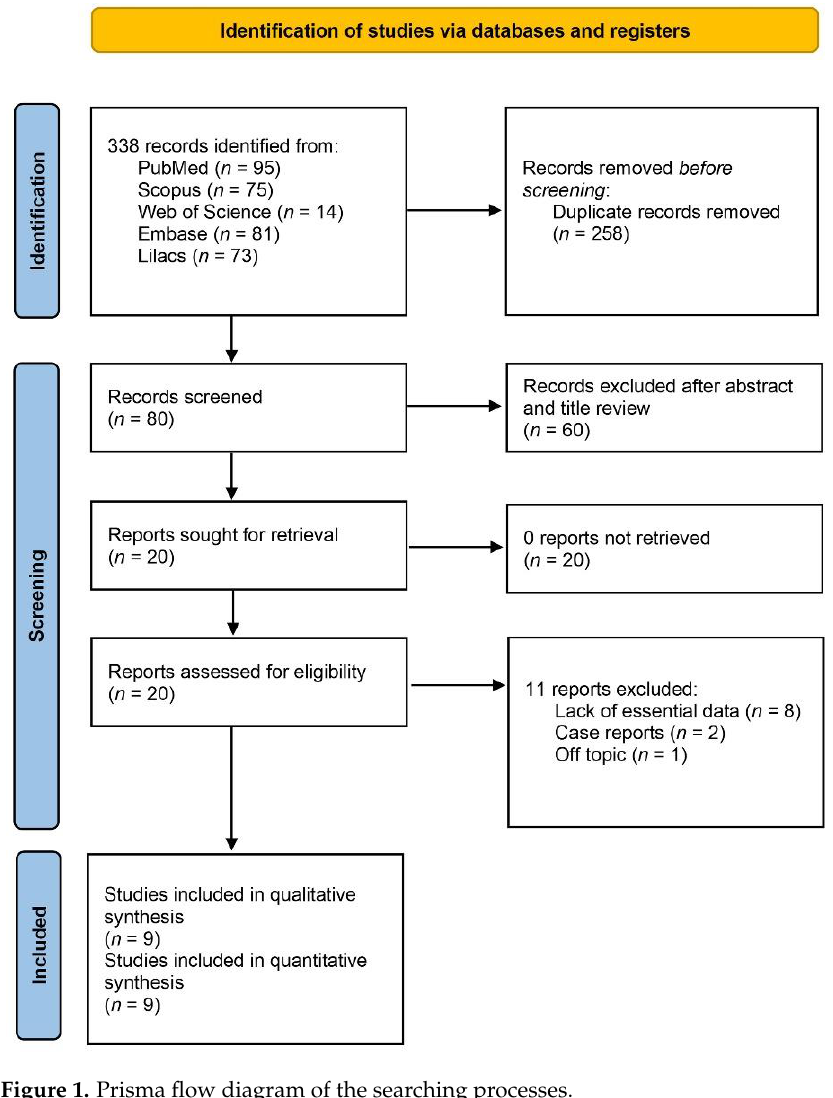
Figure 1. Prisma flow diagram of the searching processes.